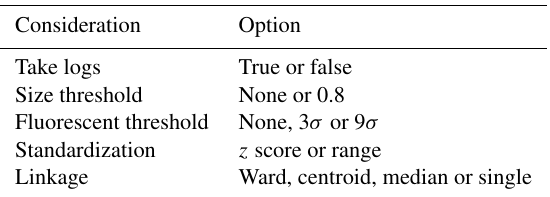
Table 5. Outline of the different approaches tested when using hi- erarchical agglomerative